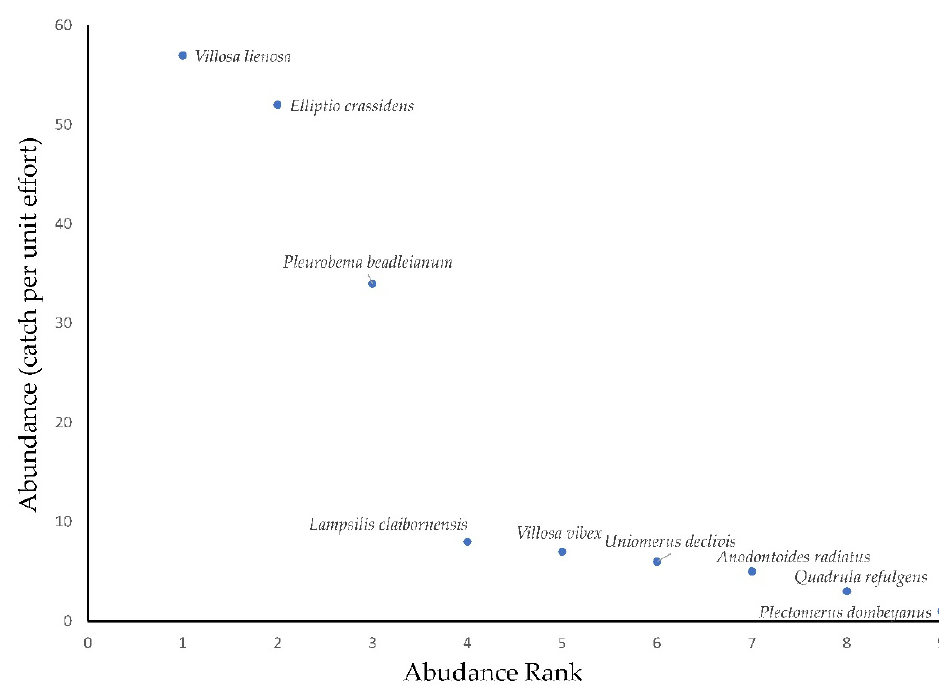
Figure 2. Relationship between species abundance and abundance rank across all sites.